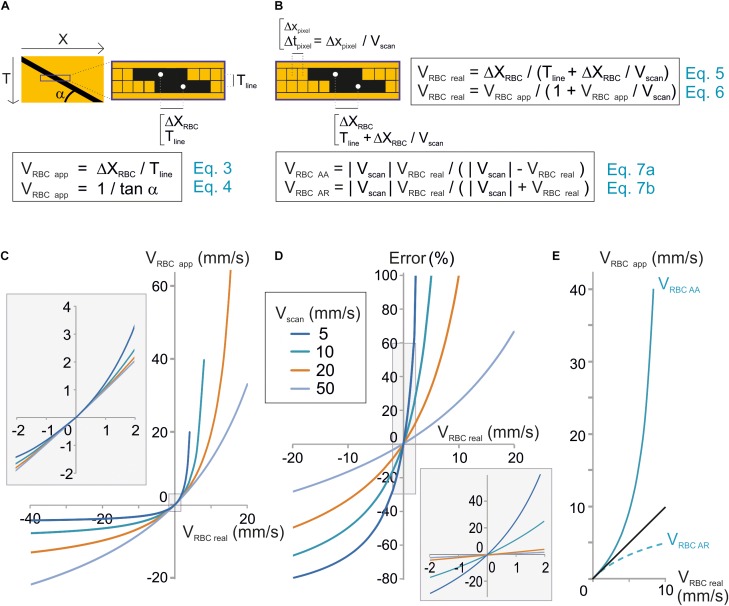
Unbiased measurement of RBC velocity. (A) Standard analysis used to calculate the apparent velocity of a RBC (VRBCapp) in space-time images. Scheme of the image parameters. VRBCapp is the inverse of the slope of the shadow made by the RBC (angle α), which corresponds the ratio of the distance traveled by the RBC between two successive lines (ΔXRBC) divided by the time step between two lines (Tline). (B) New analysis considering individual pixel time to calculate real velocity (VRBCreal). Top: scheme of the image parameters taking into account that each pixel within a line is acquired at a different time during scanning. The time step between two consecutive pixels (Tpixel) depends on the pixel size (Xpixel) and scan velocity (Vscan). Therefore, the time to move by ΔXmov from a line to the following one is actually Tline + ΔXmov/Vscan. As a consequence, VRBCreal depends not only on Tline and ΔXmov but also on Vscan as described by Eqs 5 and 6. These equations can be reformulated to calculate the anterograde apparent velocity of RBCs (VRBCAA) and the retrograde apparent velocity of RBCs (VRBCAR) as described by Eqs 7a,b. (C) VRBCreal diverges from VRBCapp when VRBCreal ≥ 1 mm/s. VRBCapp was calculated from Eq. 7 and plot versus VRBCreal for a range of Vscan. (D) The error made by using VRBCapp instead of VRBC can reach 10s of percent. The error made by using VRBCapp instead of VRBC was calculated as (VRBCreal – VRBCapp)/VRBCreal using Eq. 7 and plot versus exact VRBC for a range Vscan. Inset: enlargement of the plot initial part. (E) Anterograde scanning overestimates RBC velocity whereas retrograde scanning underestimates velocity. VRBCAA and VRBCAR were calculated from Eqs 7a,b and plot versus VRBCreal for Vscan = 10 mm/s.